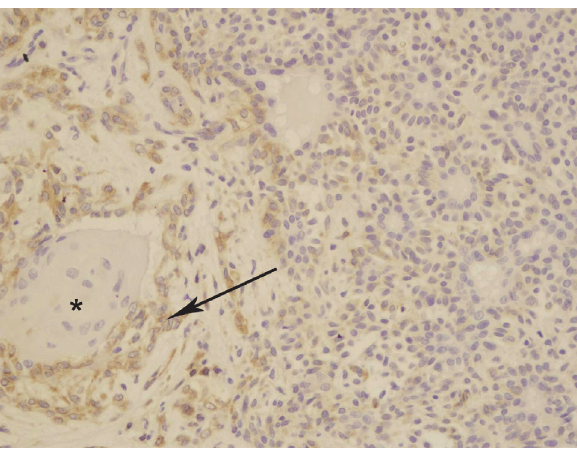
Fig. 2. Squamous cell metaplasia in pleomorphic adenoma. Negative bcl-2 immunoreaction of intercalated-duct like struc- tures on the right side of the picture. Note a squamous cell metaplasia (asterisk), surrounded by bcl-2 positive intermediate cells (arrow). Original magnification, x 200.